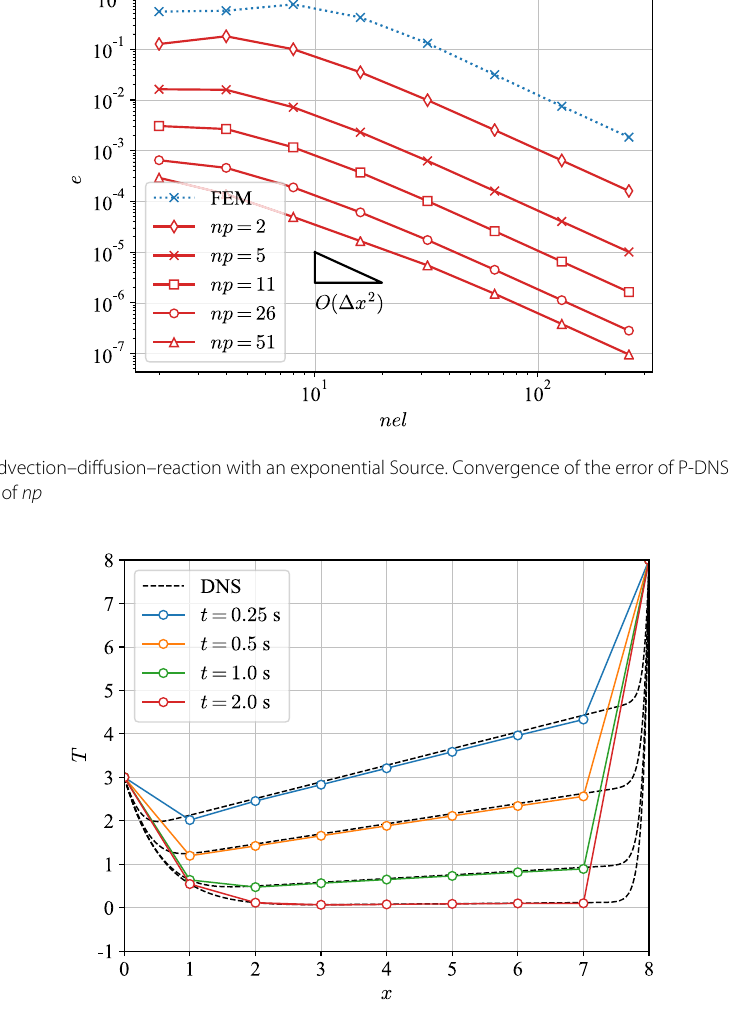
problem on a mesh of 1000 uniform-size linear elements using the standard Galerkin- FEM, a time-step size of 0.005 s, and second-order